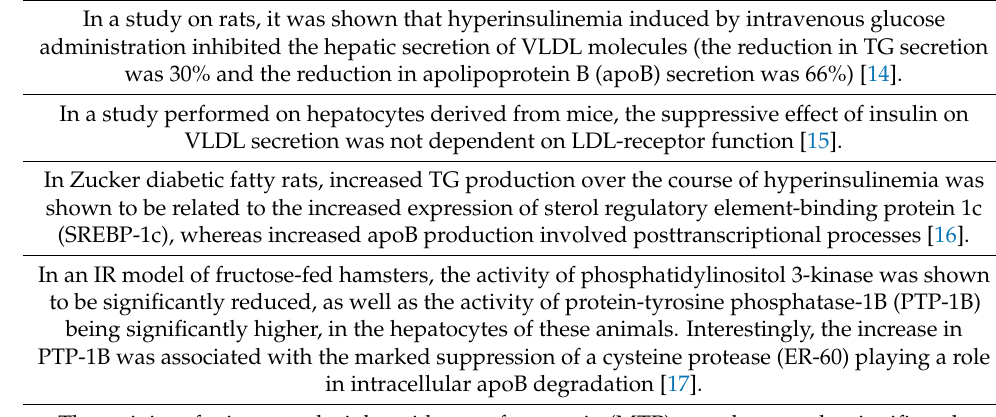
Table 1. Results of selected studies on the relationship between insulin and lipid metabolism. In a study on rats, it was shown that hyperinsulinemia induced by intravenous glucose administration inhibited the hepatic secretion of VLDL molecules (the reduction in TG